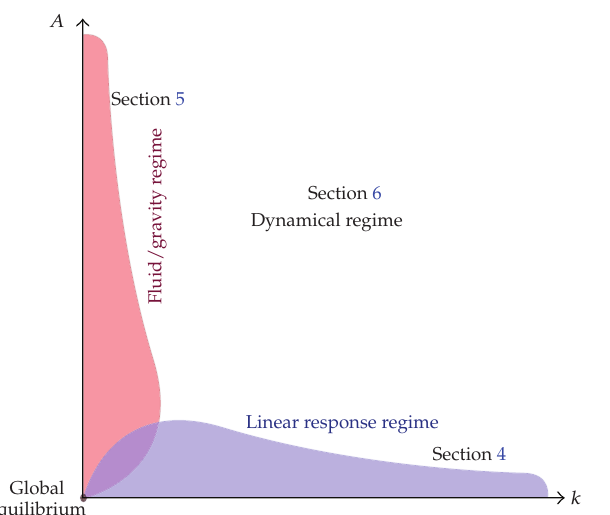
Figure 1: Rough indication of the regimes of validity of the linear response theory and the fluid/gravity correspondence, in the space of perturbations from global thermodynamic equilibrium, labeled by the amplitude of perturbations A and the wave number (cid:3) or frequency (cid:4) k (cid:7) (cid:4) mfp /L , relative to the microscopic scale. We have indicated the relevant sections of the paper where the di ff erent regimes are discussed from the holographic